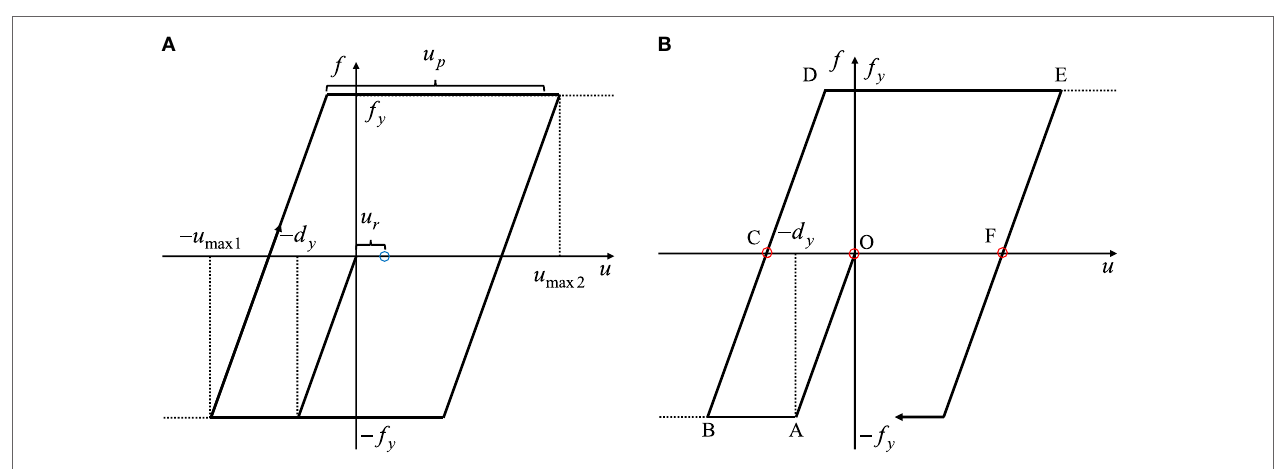
FigUre 3 | Three input sequences: (a) input sequence 1: multiple impulse input with equal interval; (B) input sequence 2: multiple impulse input with modification of first impulse timing; (c) input sequence 3: multiple impulse input with modification of first impulse timing and first impulse amplitude .